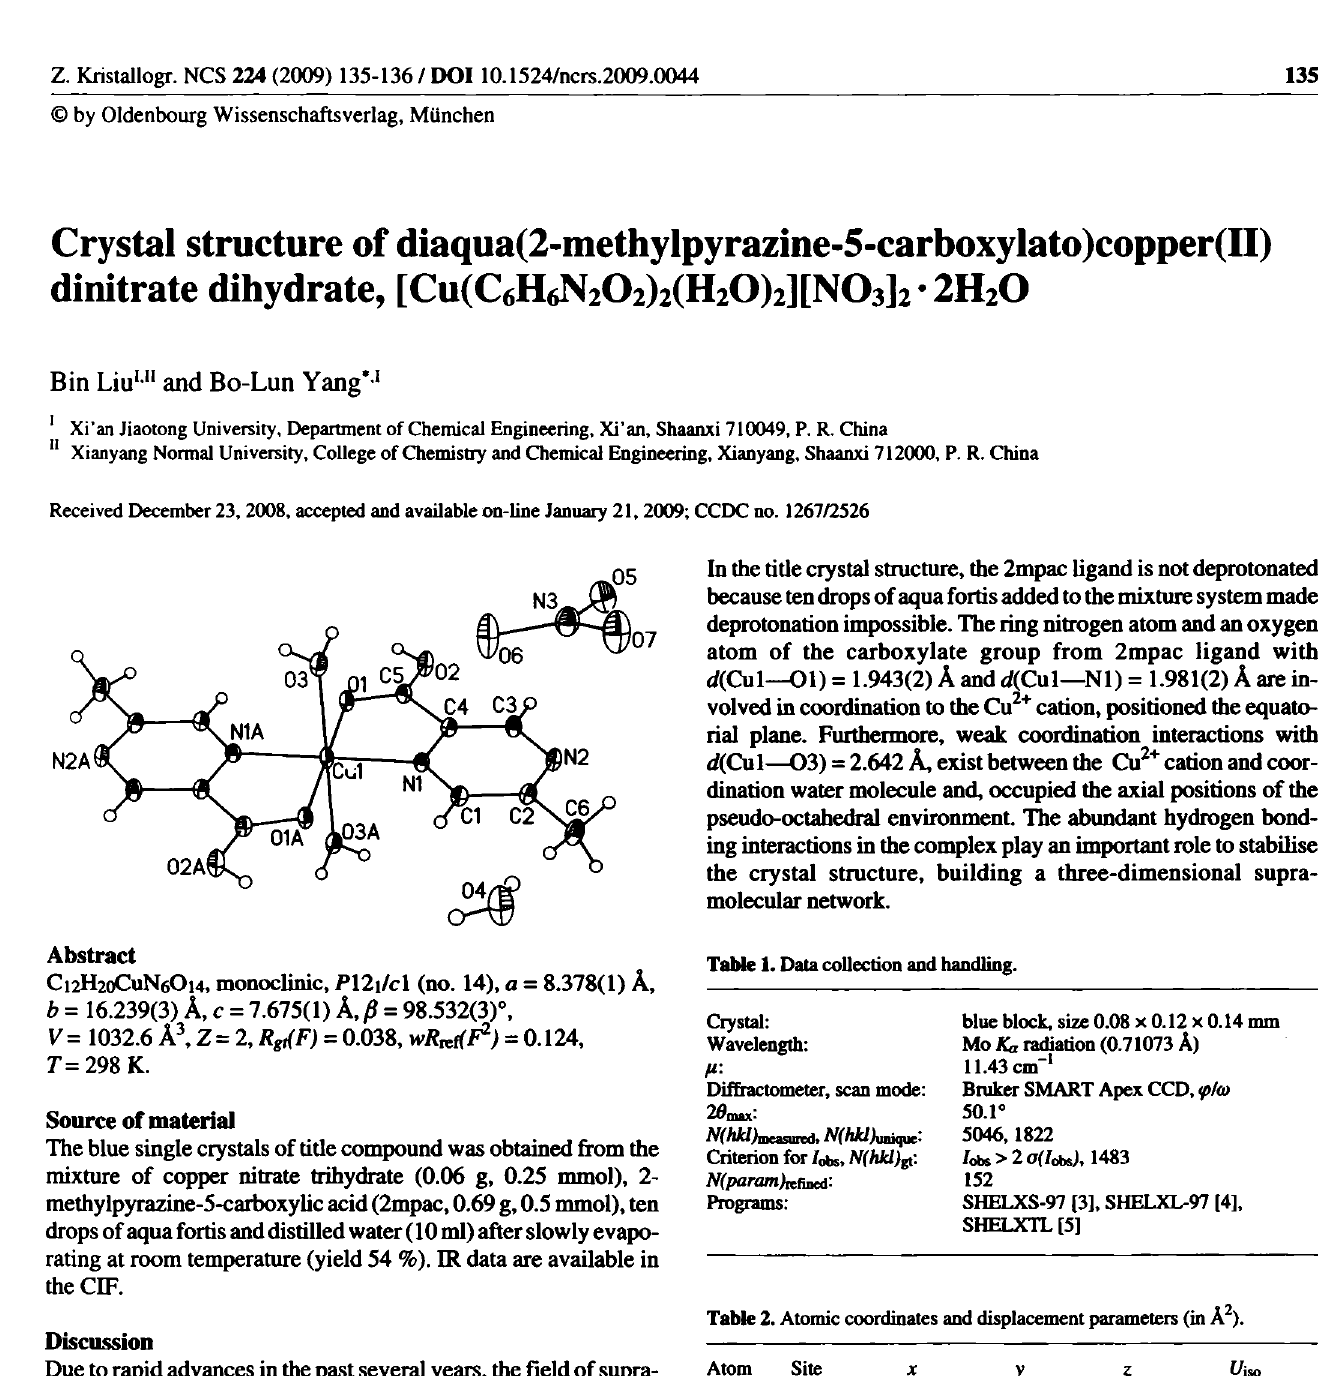
Table 2. Atomic coordinates and displacement parameters (in À 2 ).